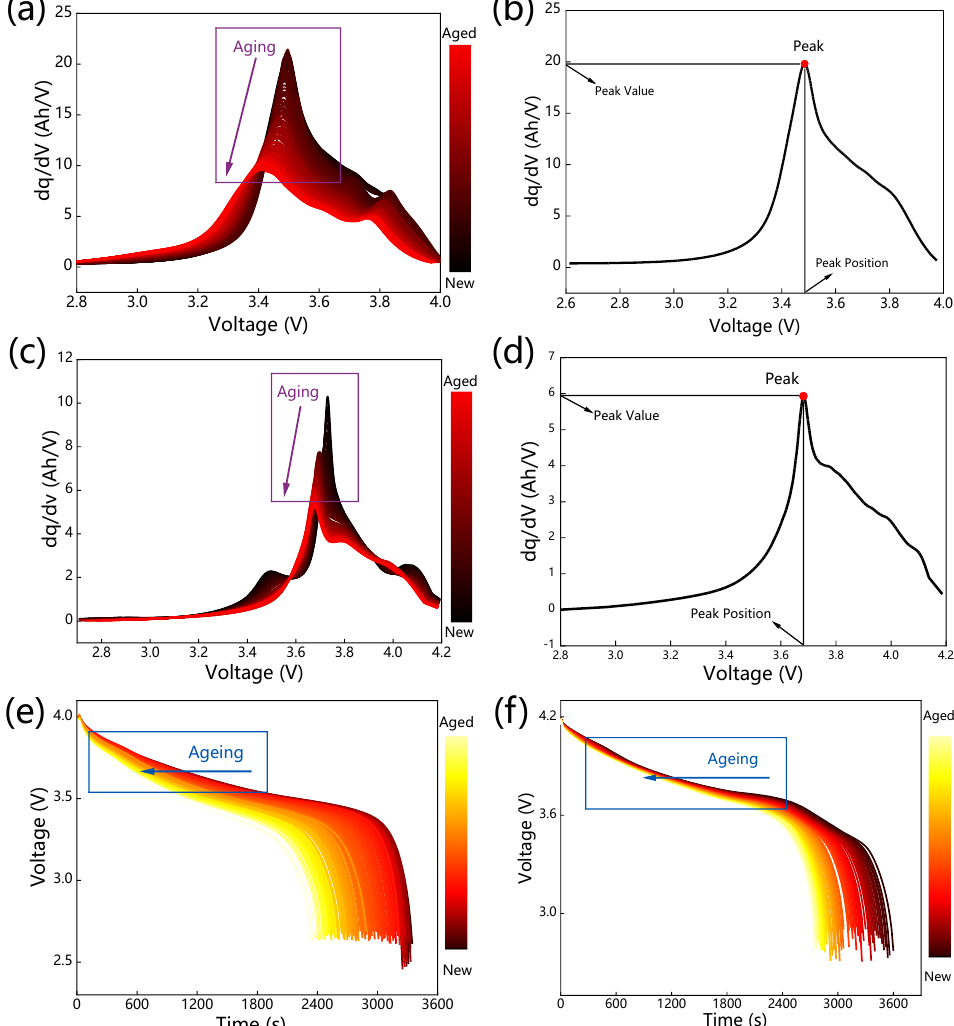
Figure 3. IC and TVC analysis: ( a ) IC curves and ( b ) IC feature variables of battery B5 in the NASA dataset; ( c ) IC curves and ( d ) IC feature variables of cell 1 in the Oxford dataset; ( e ) Time-voltage curves for battery B5 in the NASA dataset and ( f ) Time-voltage curves for cell 1 in the Oxford dataset.